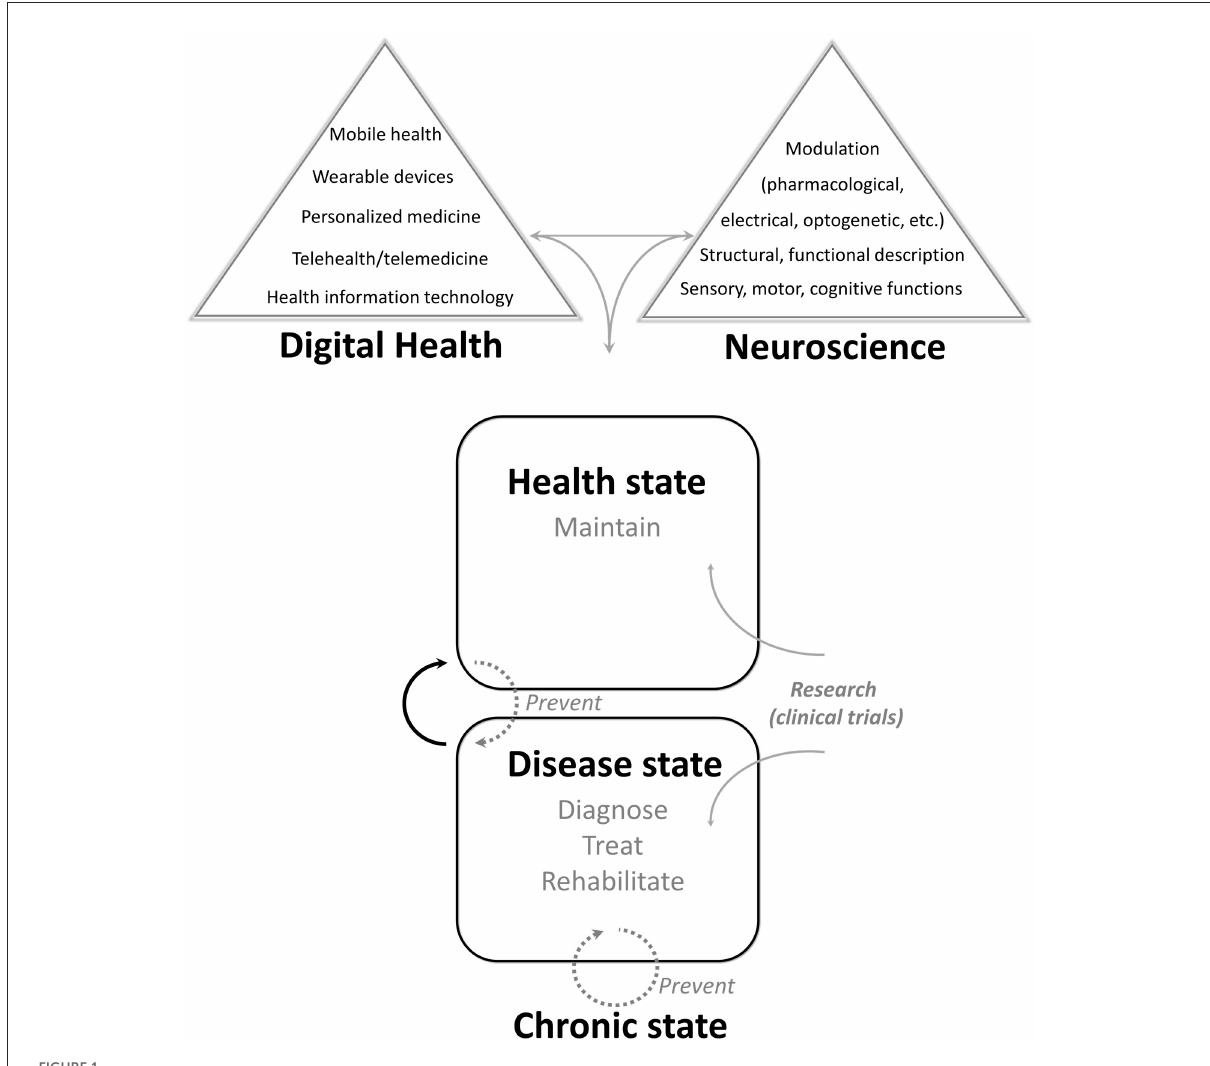
FIGURE1 Digital health and